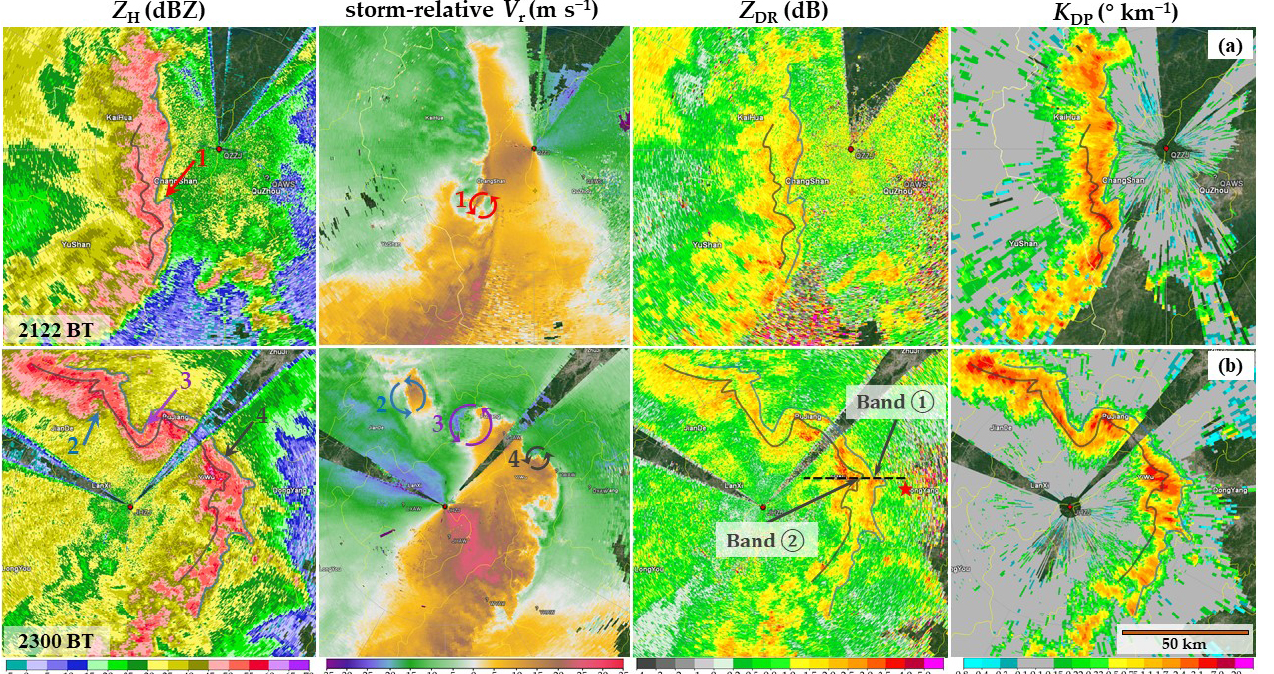
Figure 7. Composite PPIs of Z H , storm-relative V r , Z DR , and K DP at elevation angles of ( a ) 0.5° and ( b ) 1.5° measured by ( a ) QZ-SPOL and ( b ) JH-SPOL at ( a ) 2122 and ( b ) 2300 BT on 10 May 2021. Arrows point to the vortices on the reflectivity panels. Vortices are numbered and circled in diverse colors on the velocity panels. The solid blue and black lines represent the leading edge of the high- Z DR band on the right and left sides, respectively.